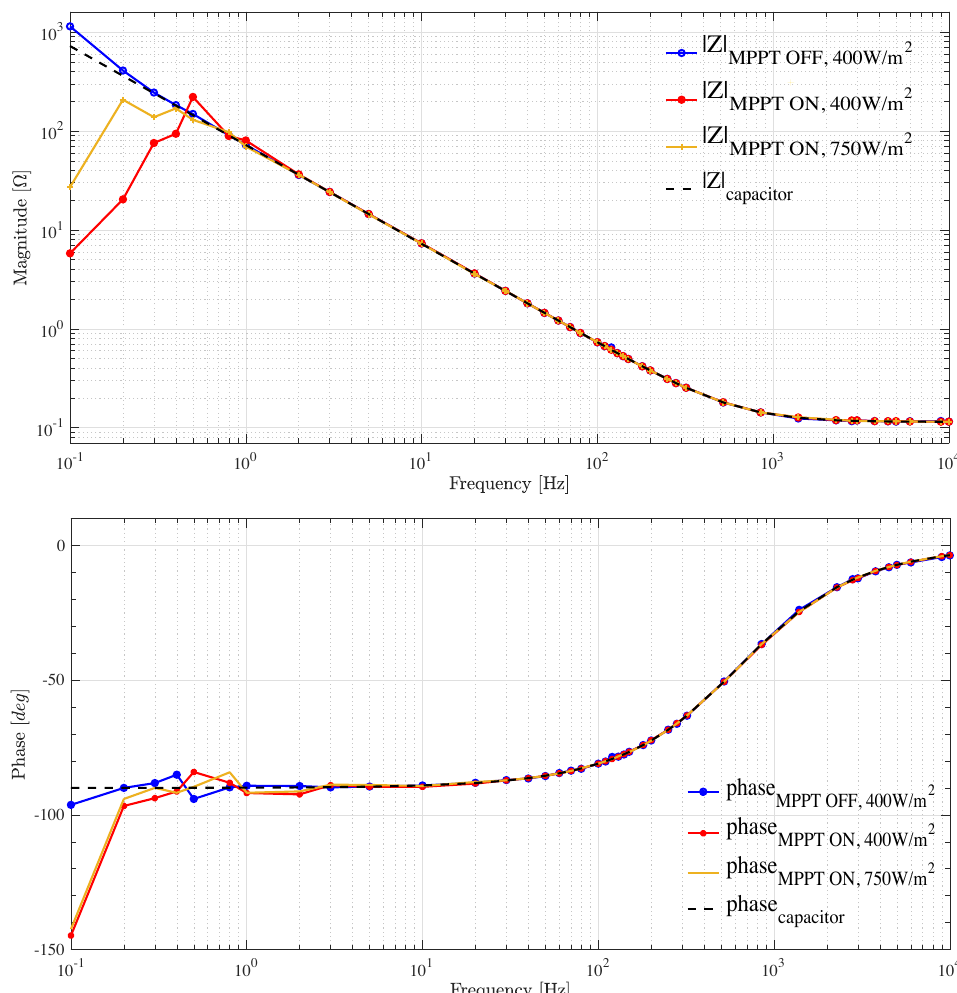
Figure 9. Impedance of DC-link capacitor by using the EIS approach in different operating